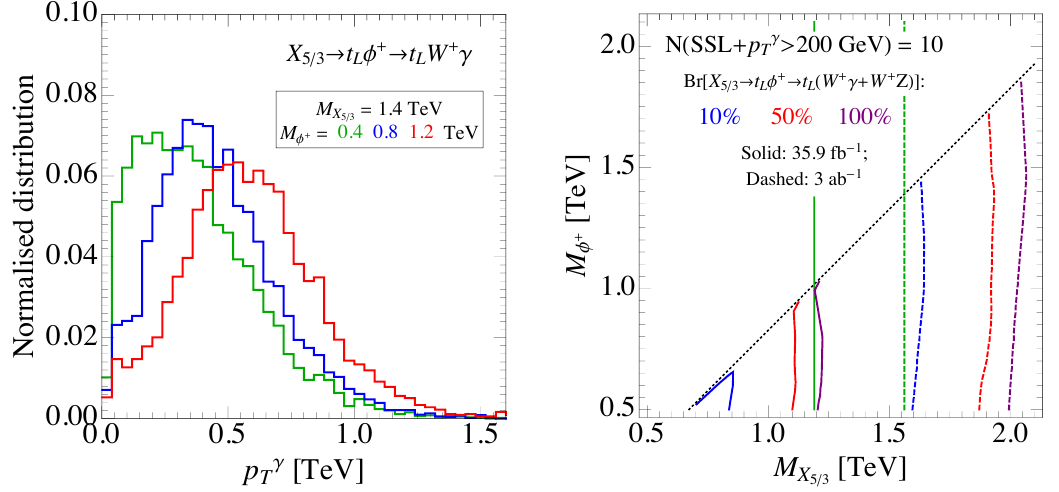
Figure 5 . Left: distribution of the transverse momentum of the leading photon in signal events which pass all SSL cuts, for M X 1 : 2 TeV. Right: contours in the M X cut-(cid:13)ow described in this subsection. Blue, red, and purple lines correspond to a Br( X 10% ; 50% ; 100%. Solid lines assume 35.9 fb (cid:0) 1 while dashed lines assume 3 ab (cid:0) 1 . The bounds and projections for the standard Br( X